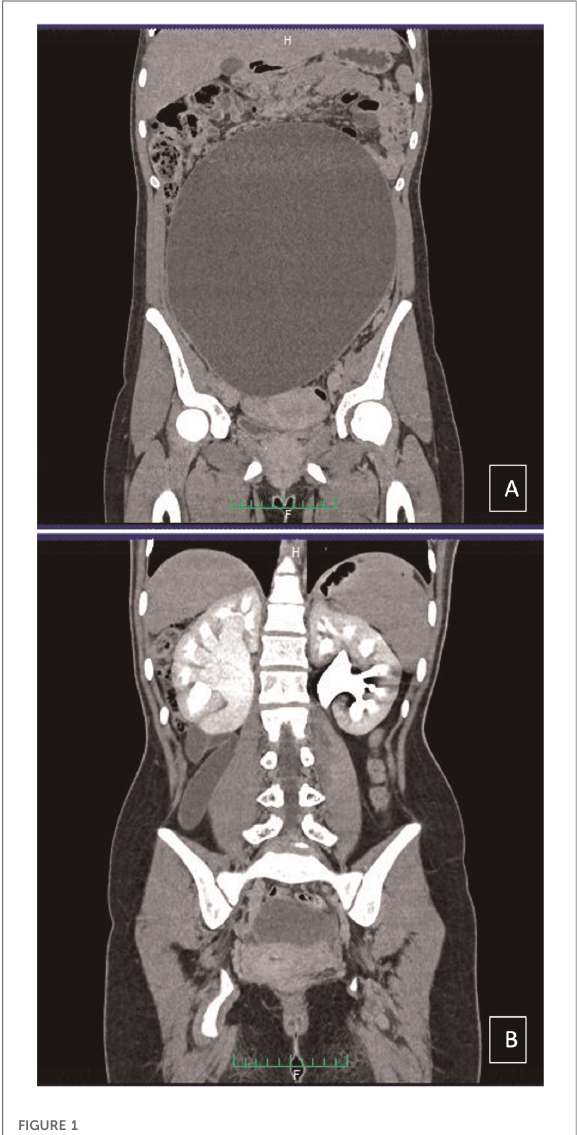
FIGURE 1 Computed tomography scan of the of giant paratubal cyst of 196 mm×90 mm×267 mm, coming from the pelvis and occupying all the four abdominal quadrants ( A ) and causing a IV grade hydronephrosis on the right kidney ( B